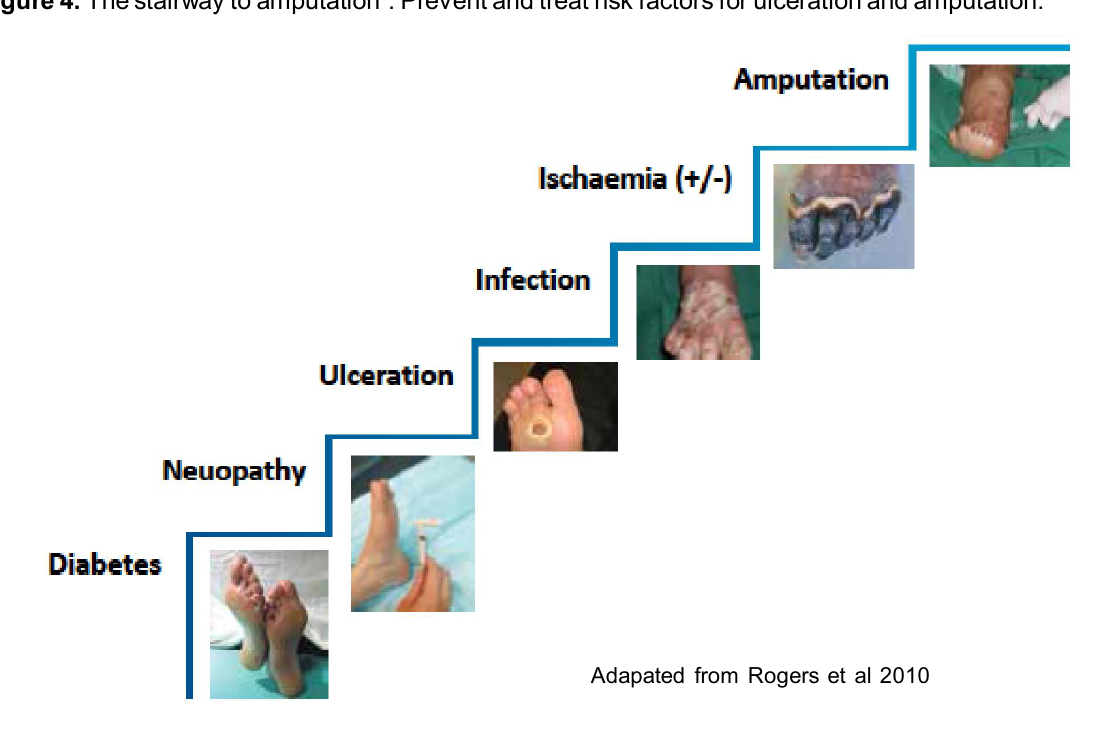
Figure 4. The stairway to amputation 3 . Prevent and treat risk factors for ulceration and